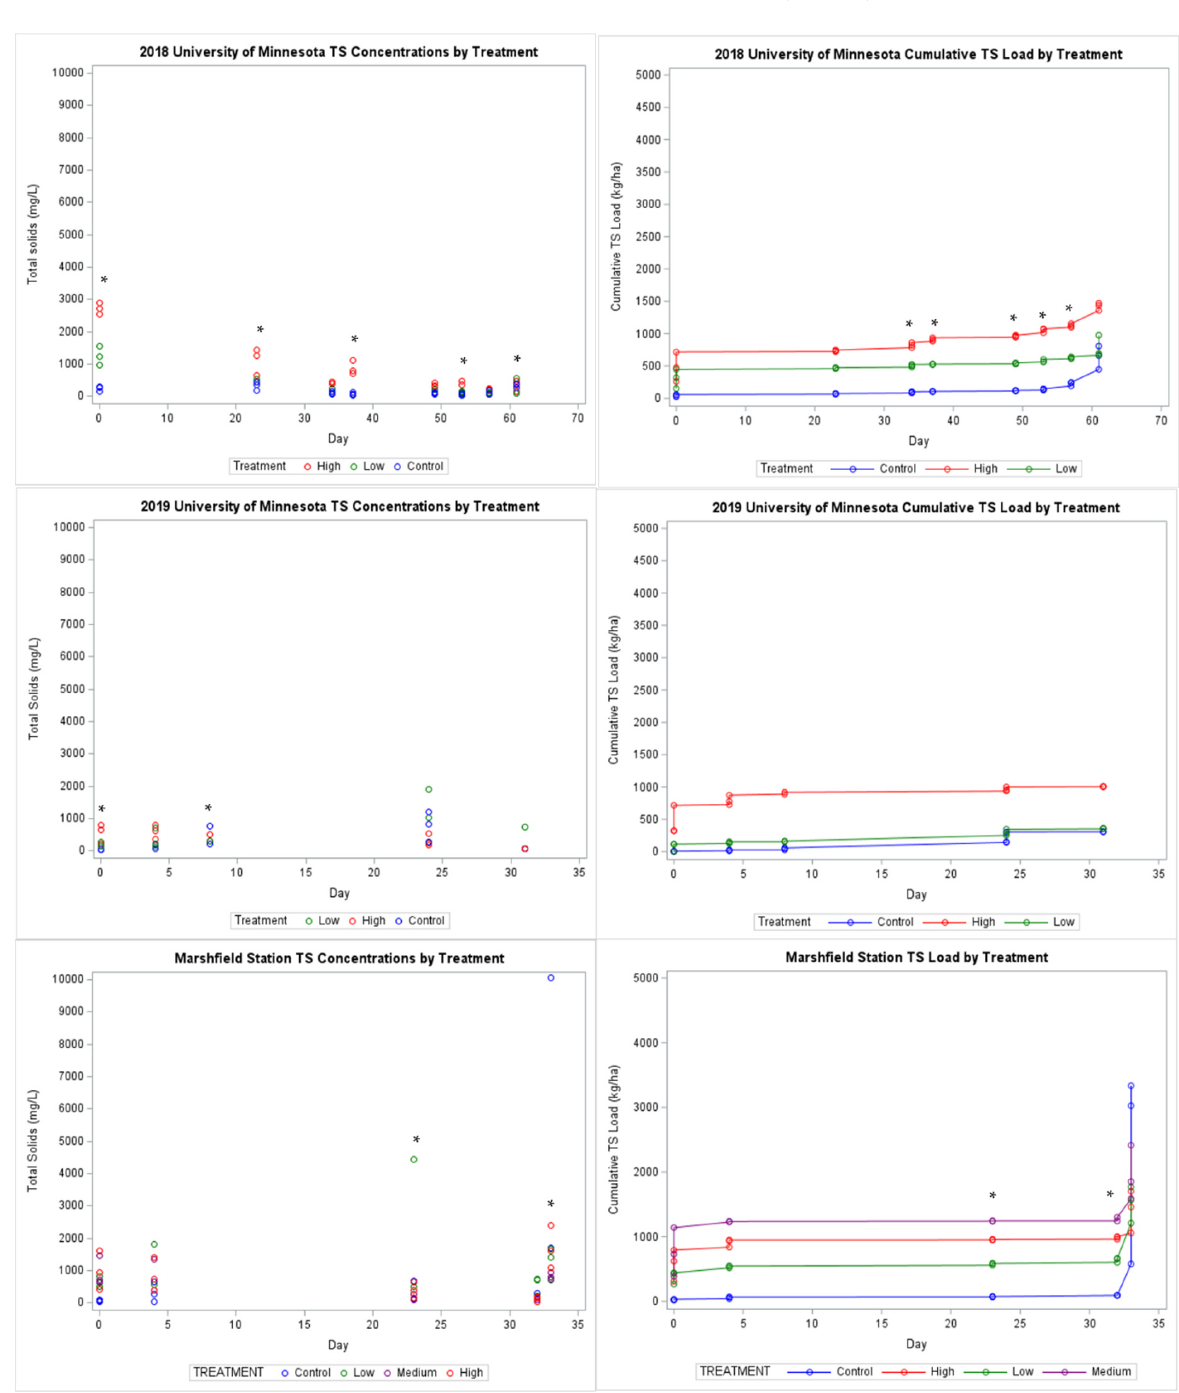
Figure 6. Snowmelt runoff total solids (TS) concentrations and loads by treatment for each site and